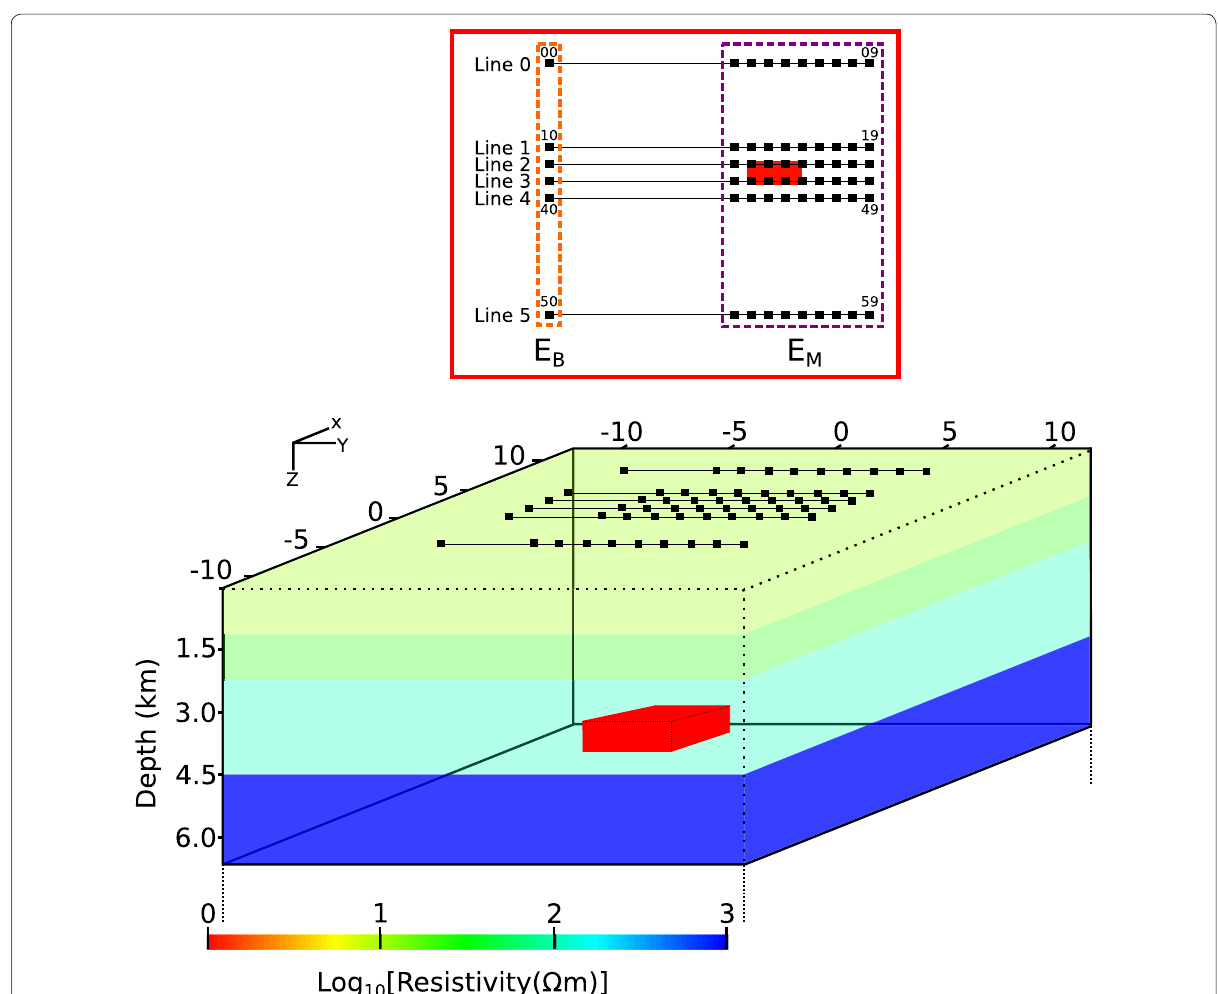
Fig. 2 Resistivity model used for the 3D synthetic forward modelling study. The red box shows a birds eye view of the six lines, with each black square representing one site. The orange dashed box shows the respective base sites ( E B ) used for each line, and the dashed purple box shows the measured sites ( E M ). The location of the red conductive block at 3.6 km depth is